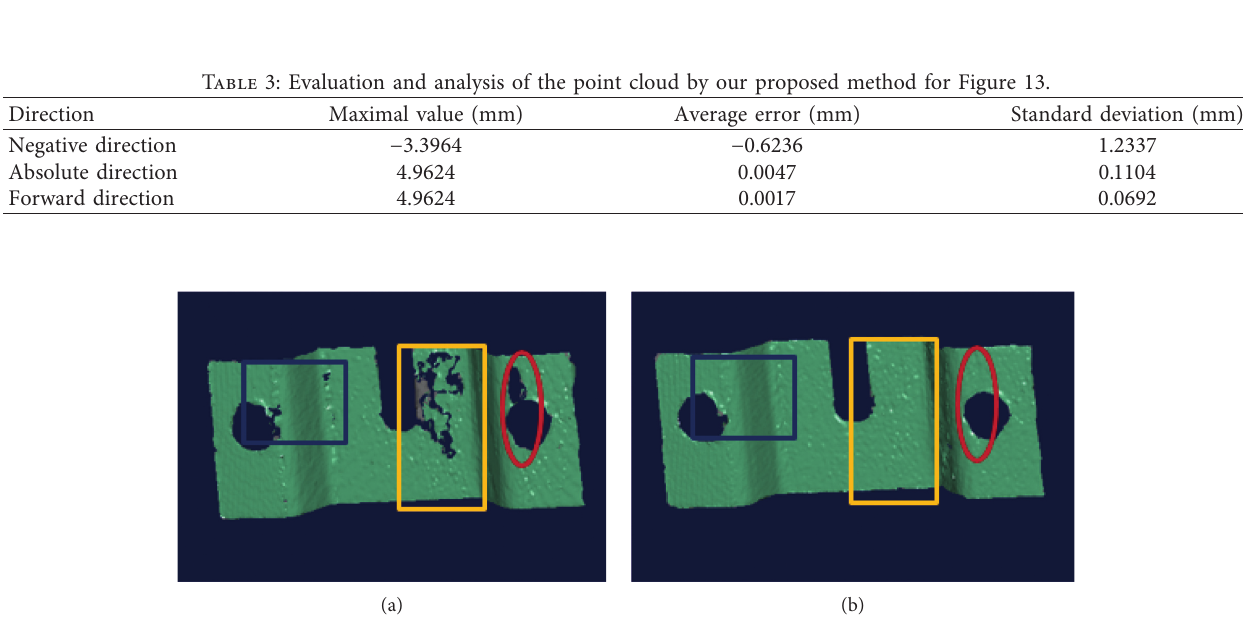
Figure 14: Comparison of experimental results of the 3D reconstruction with reflection coefficient from 0.60 to 0.75: (a) traditional ADFP method; (b) our method.